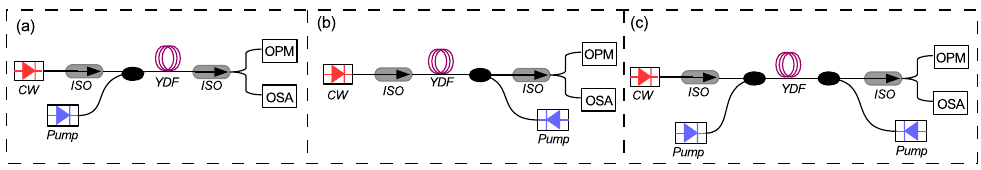
Figure 2. YDFA under different pumping configurations: ( a ) forward; ( b ) a backward; ( c )